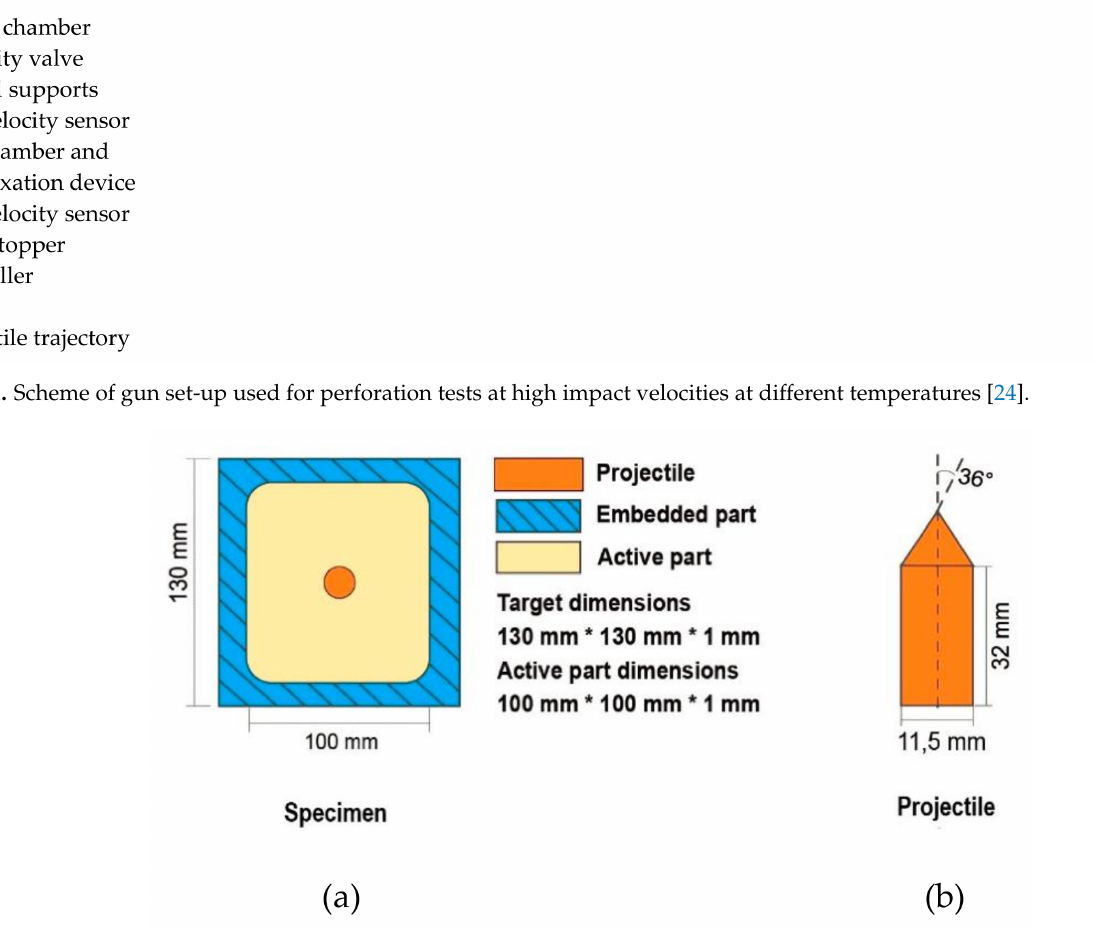
Figure 2. Details of ( a ) impacted panel and ( b ) projectile